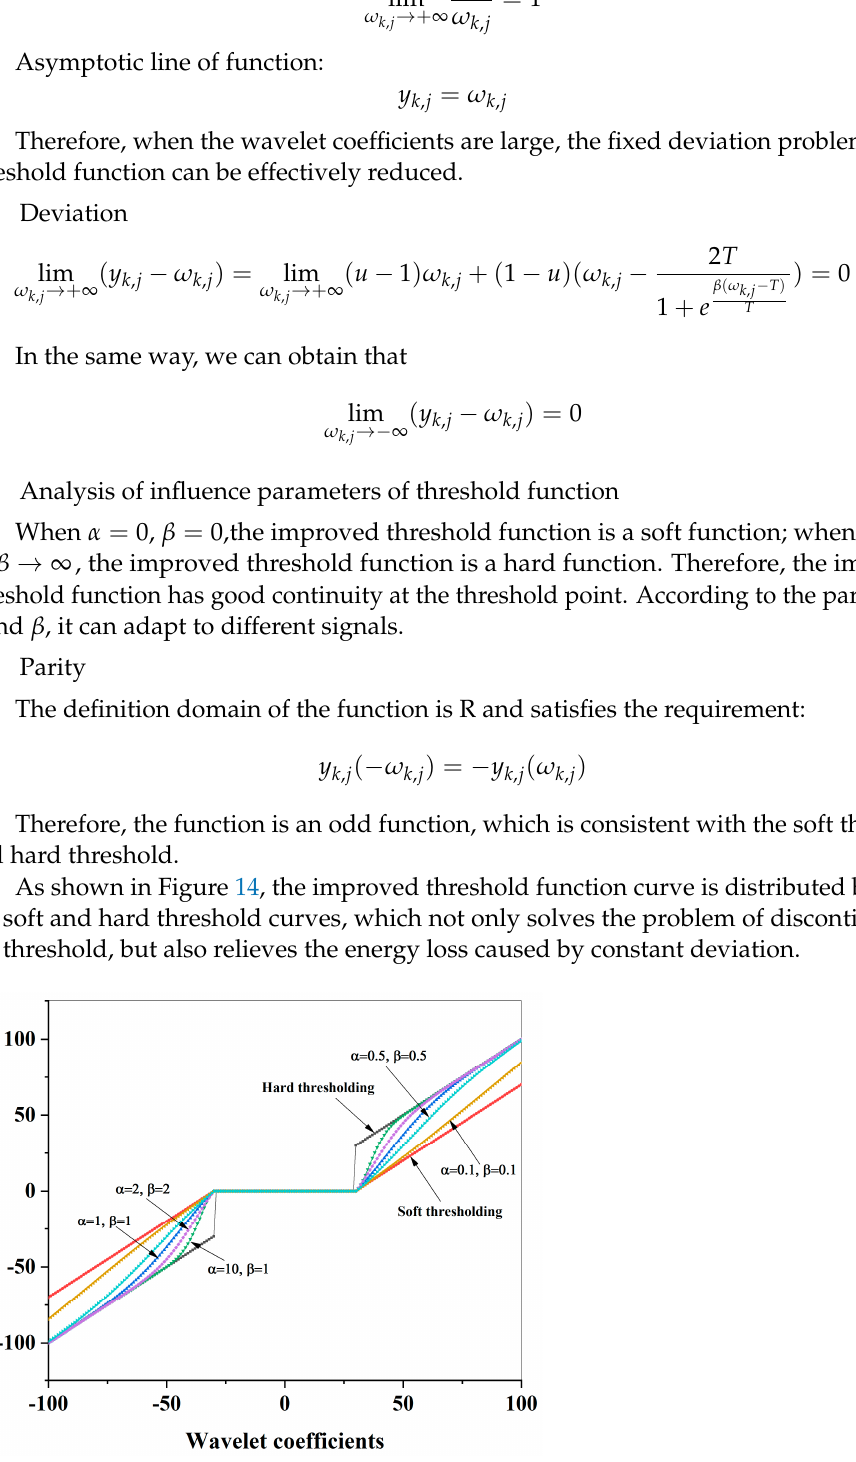
Figure 14. Comparison of hard threshold, soft threshold, and improved threshold